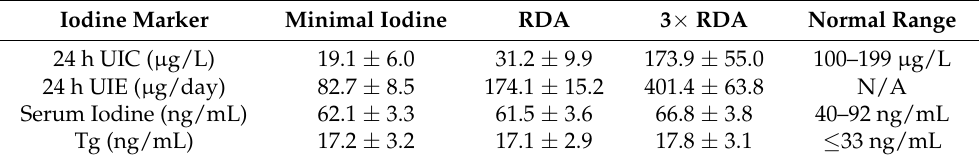
Table 2. Titration Diet Effects on Markers of Iodine Status (Mean ±